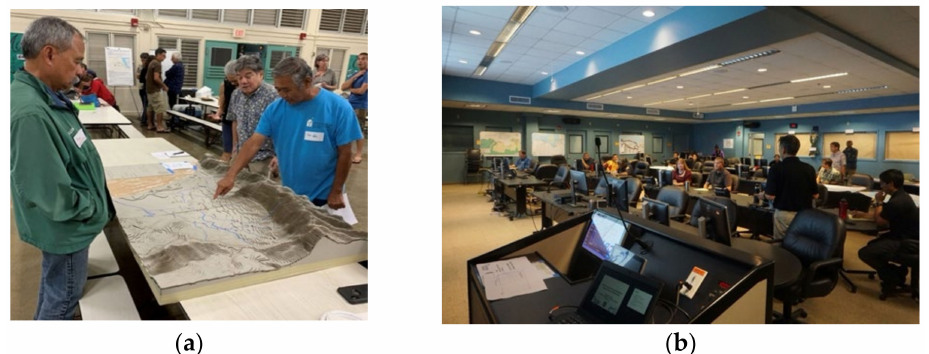
Figure A1. ( a ) Left : Physical model used to collect damage information and feedback on mitiga- tion strategies; ( b ) Right : Stakeholder workshop at held at Kaua’i Emergency Operations Center. Source: